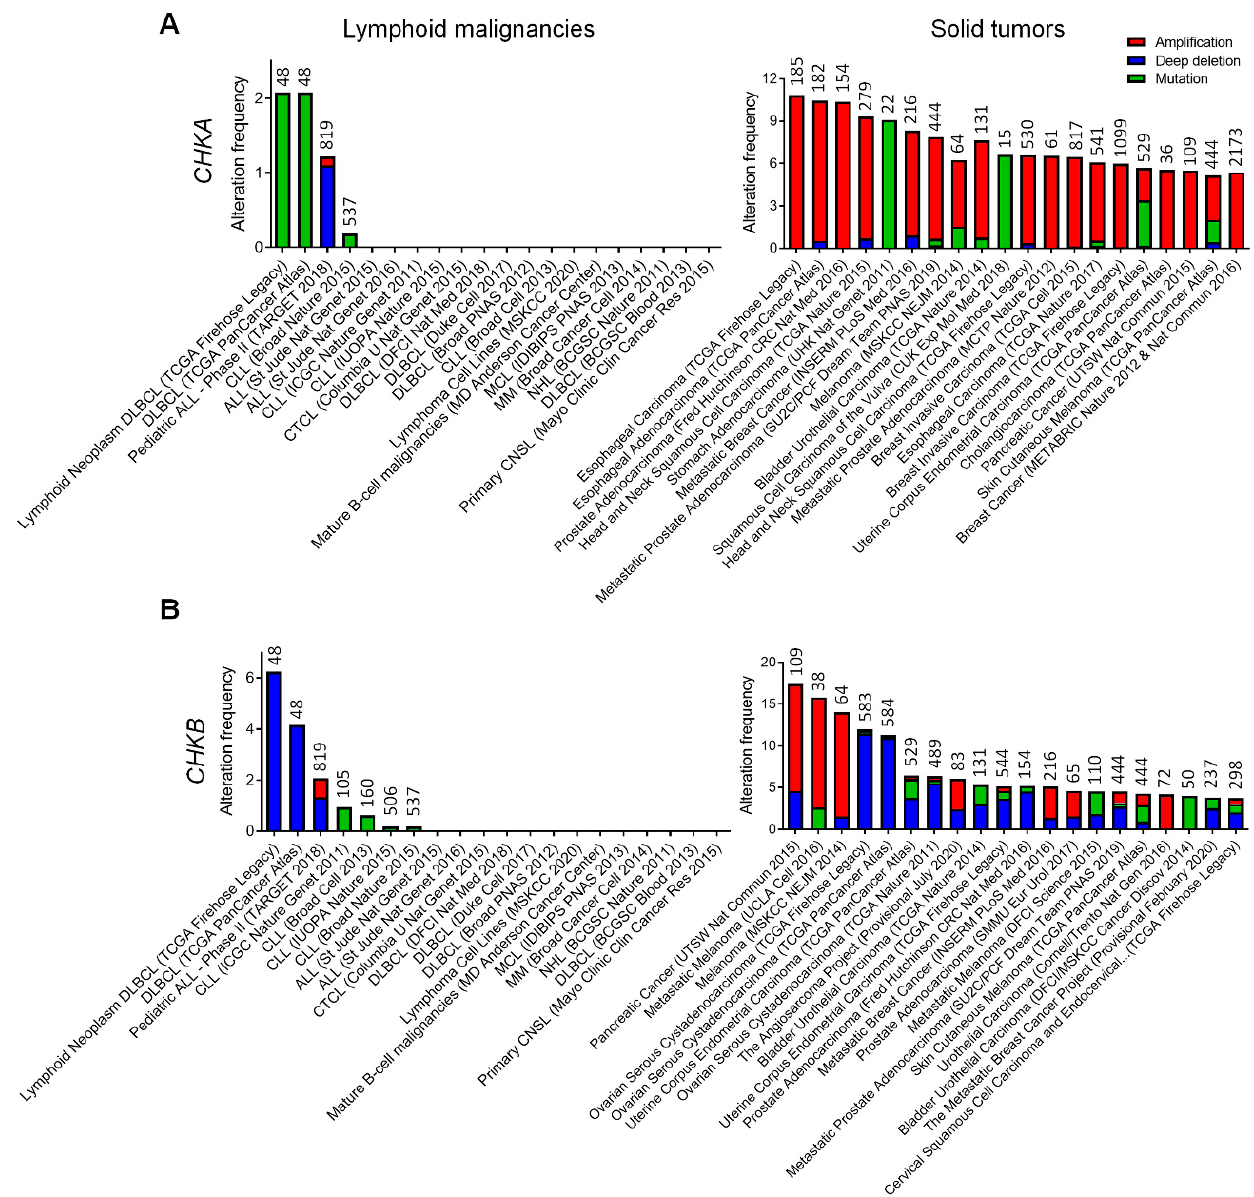
Figure 1. Genetic alterations of choline kinase in lymphoid malignancies versus solid tumors. Representative results of CHKA ( A ) and CHKB ( B ) are retrieved from TCGA. All the datasets of lymphoid malignancies available at TCGA are shown, while twenty datasets of solid tumors that exhibit a relatively higher frequency of genetic alterations are selected and presented in the graphs. Genetic alterations shown include amplification (copy number gain), deep deletion (copy number loss) and mutation (including missense mutation, frameshift insertion or deletion, and in-frame insertion or deletion). The sample size of each dataset is indicated on top of each bar in the graphs.